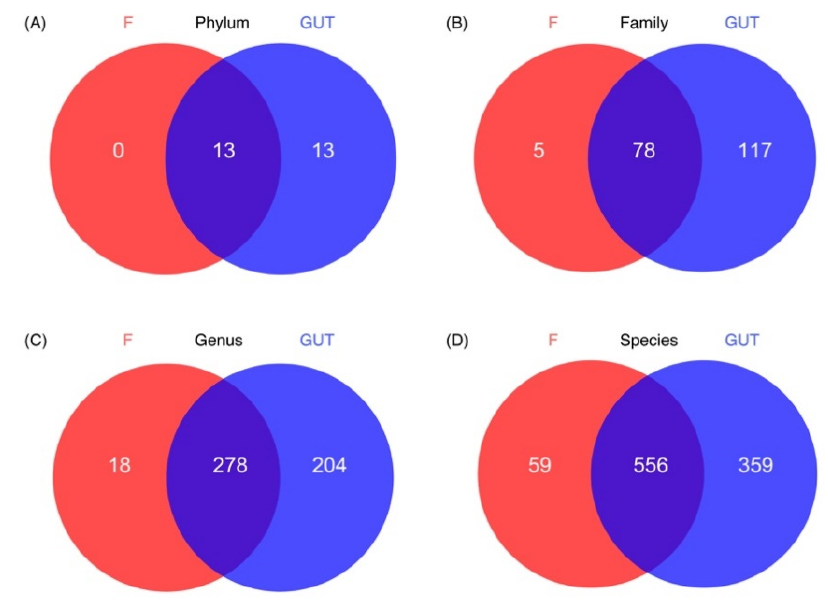
Figure 4. Characteristics of the gut microbiome in the MDD and control cases. Venn diagrams show the unique OTUs in the MDD (F, red) and control (GUT, blue) groups at the phylum ( A ), family ( B ), genus ( C ) and species ( D ) levels, as well as the number of overlapped OTUs between the two groups.